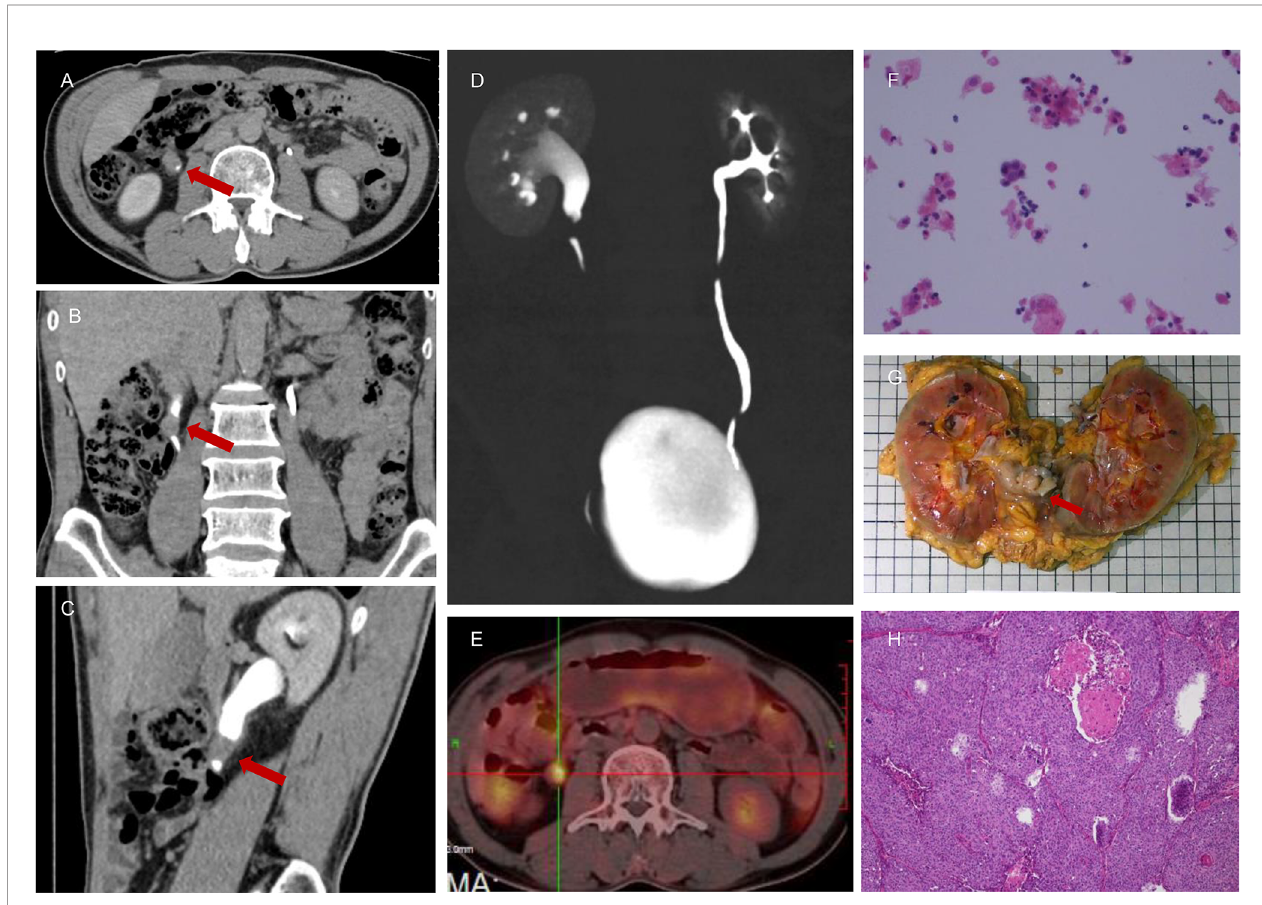
FIGURE 3 | A 55-year-old male presented with persistent painless gross hematuria for 1 month. The results of CTU indicated malignant tumor (1.2 cm * 1.7 cm) of the right ureter (A – D) . There were nuclear heterogeneous cells suggested by urine cytology that were regarded as malignant tumor cells (F) , and the NLR value was 3.99. Intense 18F-FDG uptake was also noted in the right upper ureter (E) , which indicated a high probability of malignant tumor. This patient was subjected to right RNU, and the fi nal pathological report con fi rmed a diagnosis of right upper ureteral carcinoma (G, H)